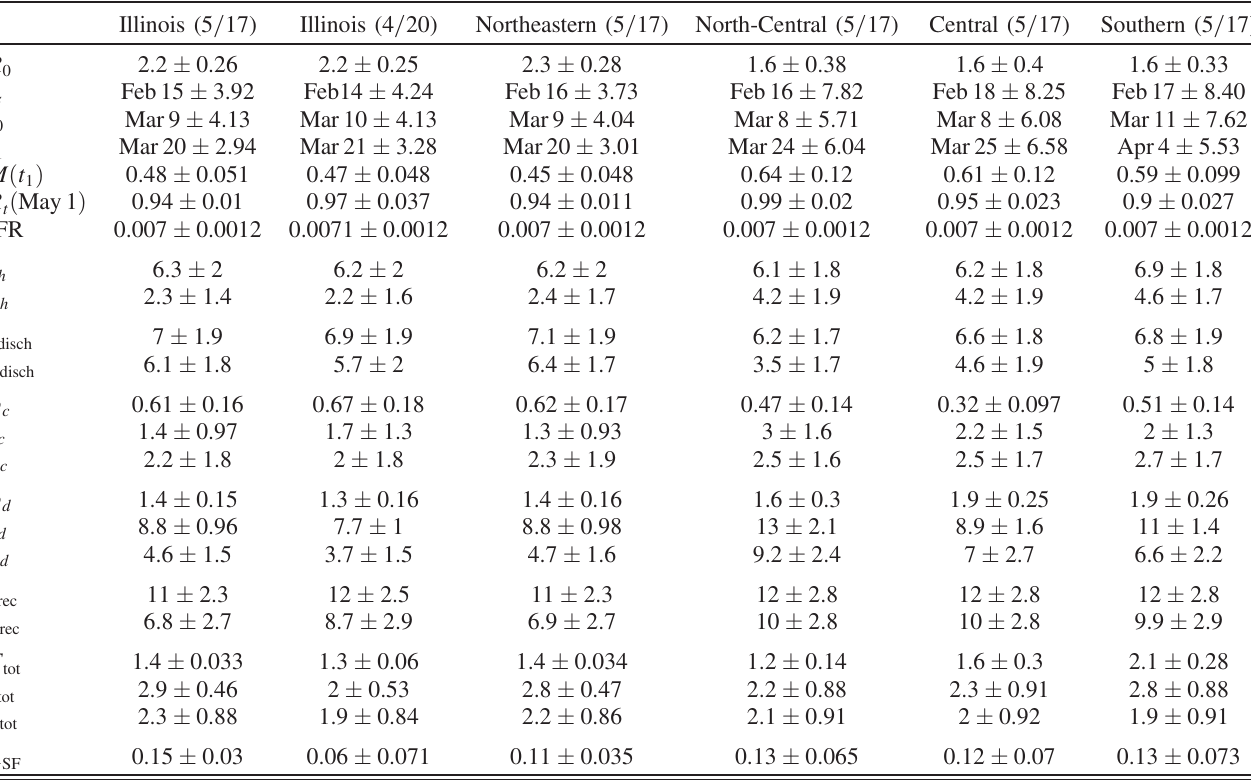
TABLE III. Table of inferred model parameters for disease severity and the time dependence of mitigation effects. Mitigation was modeled with a piecewise Hermite cubic interpolating polynomial as described in Sec. II A. Each column reports median parameter values from the MCMC algorithm for the different model fits, along with the largest of the upper and lower 1 σ error bounds reported by the algorithm. In addition, we report the (derived) values and uncertainties of R t [as defined in Eq. (3)] for each model, as evaluated on May 1, 2020. The column headers specify the modeled region of Illinois and the inclusive end date of the calibration